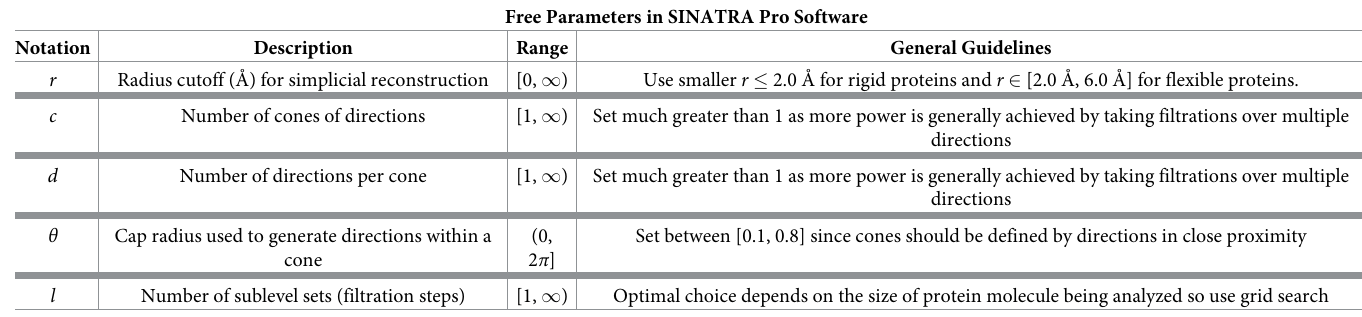
Table 1. General guidelines for choosing values for the free parameters in the SINATRA Pro pipeline software. The guidelines provided are based off of intuition gained through the simulation studies. In practice, we suggest specifying multiple cones c > 1 and utilizing multiple directions d per cone (see monotonically increasing power in S1 Fig in Supporting Information). While the other two parameters ( θ and l ) do not have monotonic properties, their effects on SINATRA’s performance still have natural interpretations. Selection of θ 2 [0.1, 0.8] supports previous theoretical results that cones should be defined by directions in close proximity to each other [13, 15]; but not so close that they explain the same local information with little variation. Note that our sensitivity analyses suggest that the power of SINATRA Pro is relatively robust to the choice of θ . Optimal choice of l depends on the size of the protein molecules that are being analyzed. Intuitively, for rigid proteins, coarse filtrations with too few sublevel sets cause SINATRA Pro to miss or “step over” structural shifts that occur locally during the course of a molecular dynamic (MD) trajectory. In practice, we recommend choosing the angle between directions within cones θ and the number of sublevel sets l via cross validation or some grid-based